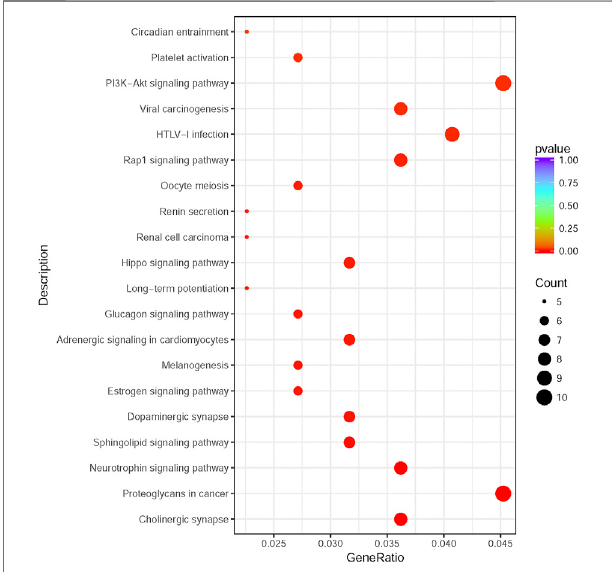
FIGURE9| KEGGpathway enrichmentanalysis.Thetop20enrichment score pathways were showed. KEGG: Kyoto Encyclopedia of Genes and